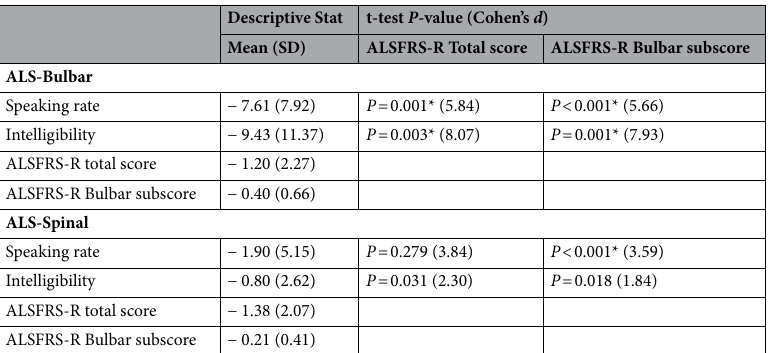
Descriptive Stat t-test P -value (Cohen’s d